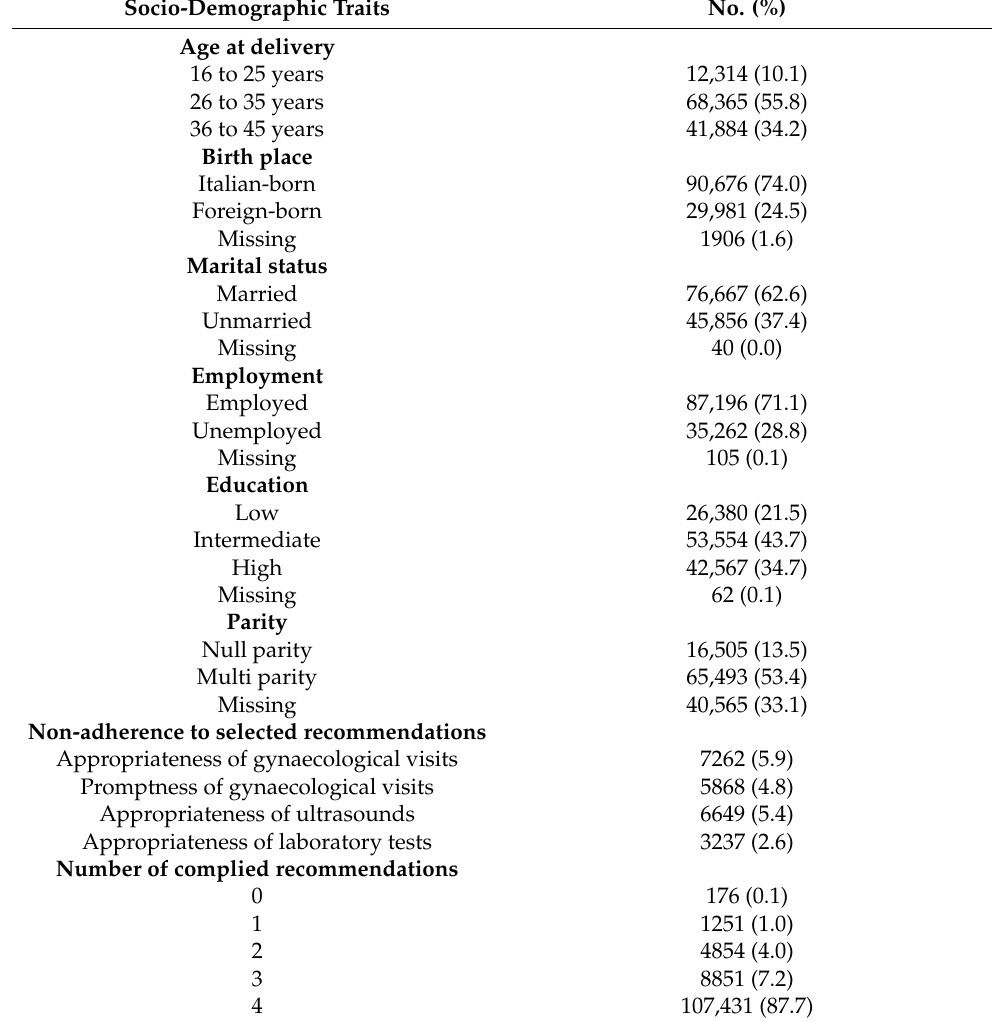
Table 1. Sociodemographic traits, parity and adherence with selected recommendation of the 122,563 mothers included in the study cohort. Italy, region of Lombardy, 2015–2017.